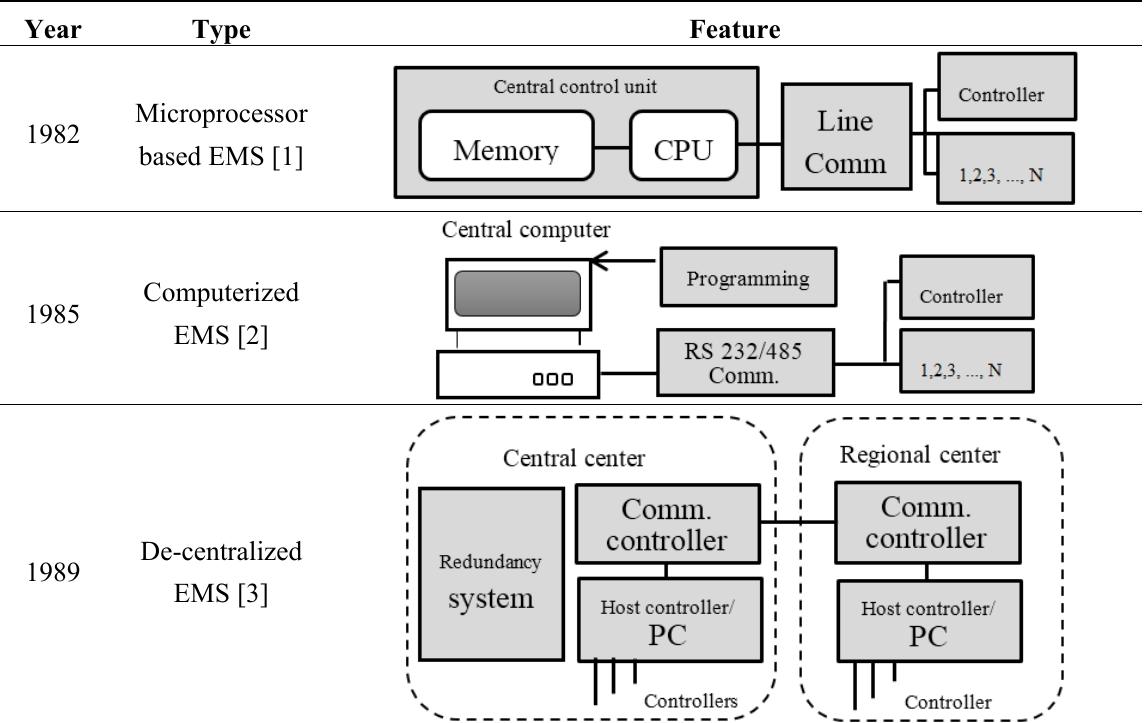
Table 1. The development of the energy management service